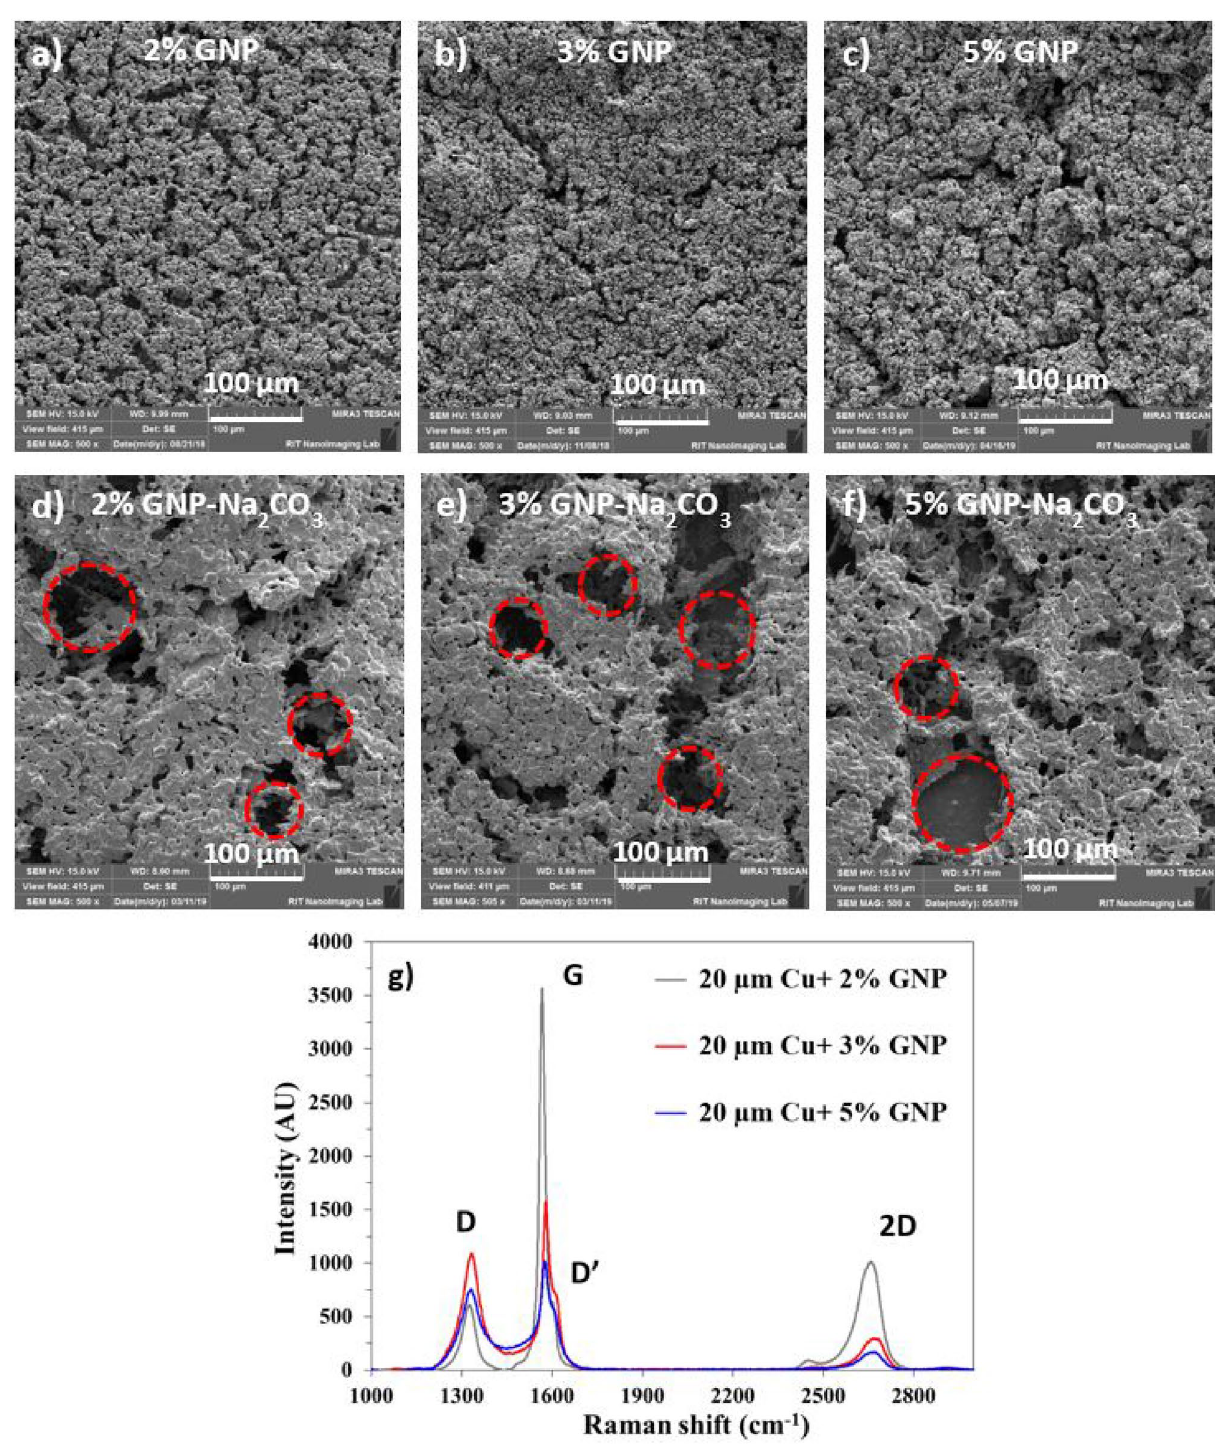
Figure 3. Comparison of scanning electron microscope (SEM) images of GNP draped 20 µm Cu coatings with ( a ) 2%, ( b ) 3%, and ( c ) 5% by weight GNP and ( d ) 2% GNP, ( e ) 3% GNP, and ( f ) 5% GNP via salt templating, and ( g ) Raman spectroscopy analysis of different wt.% GNP draped copper